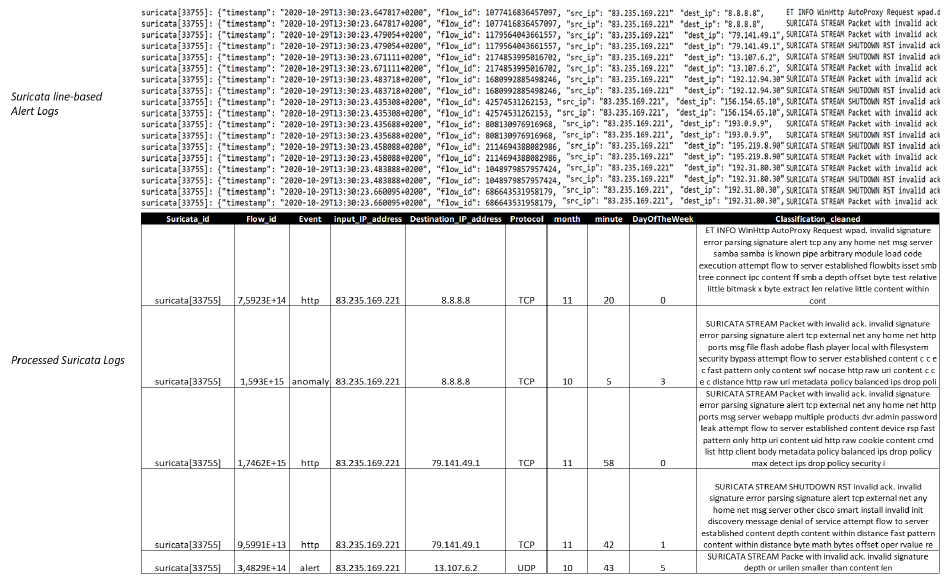
Figure 4. Suricata line-based alert logs